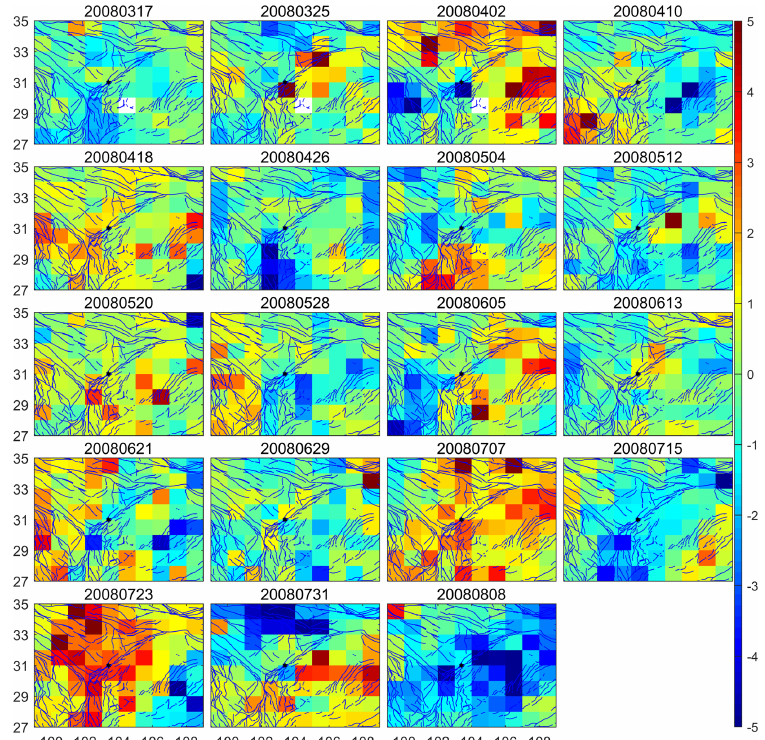
Figure 10. Distribution of the successive differential value at